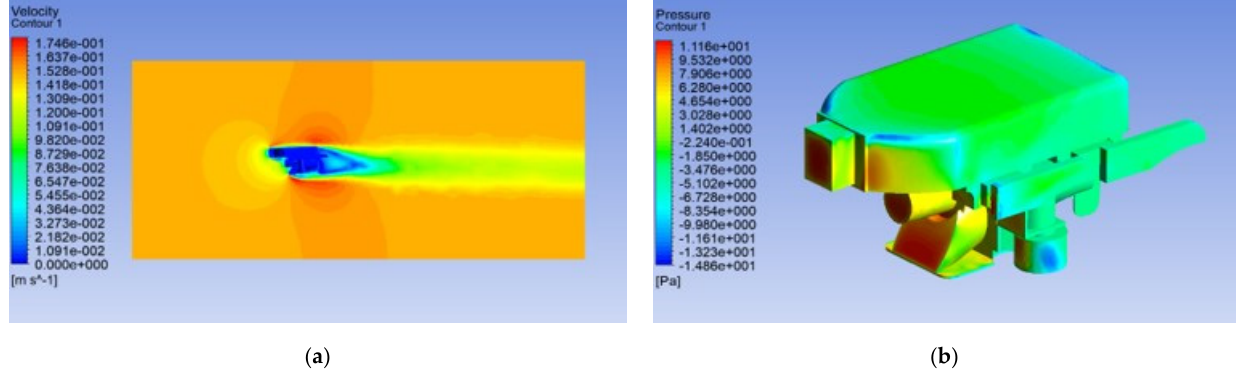
Figure 13. Simulation results in static flow field of forward motion: ( a ) result of the velocity; ( b ) result of the static pressure.